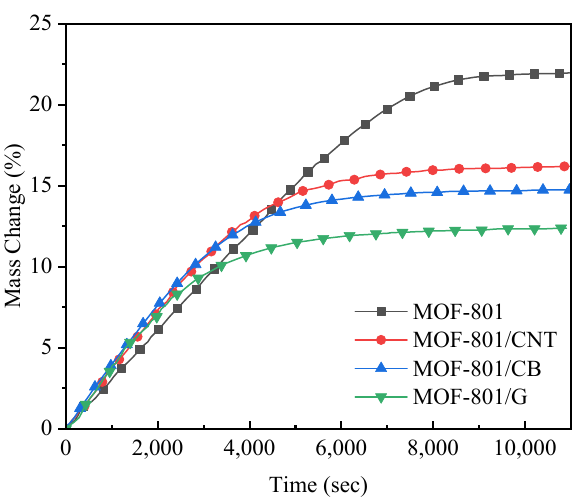
Figure 5. Adsorption curve of MOF-801, MOF-801/CNT, MOF-801/G, and MOF-801/CB at T = 25 °C and RH = 20%.